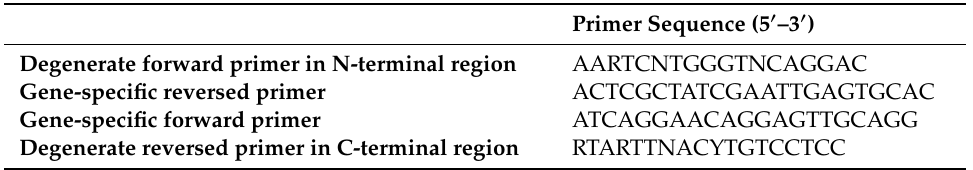
Table 1. Primers used for degenerate